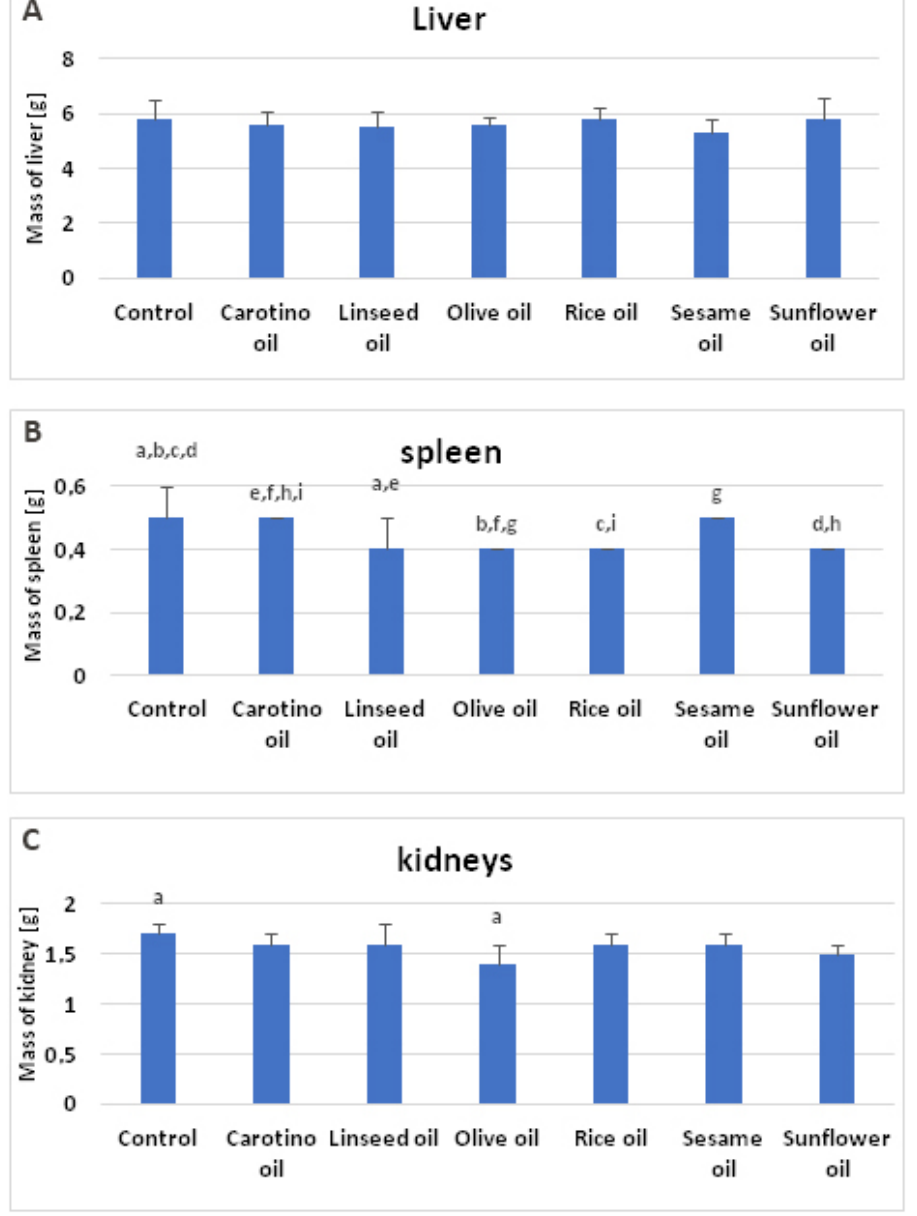
Figure 6. Organ weights of rats supplemented with selected oils ( A —mass of liver; B —mass of spleen; C —kidneys). Bars with the same superscript (a–i) above are significantly different ( p < 0.05).